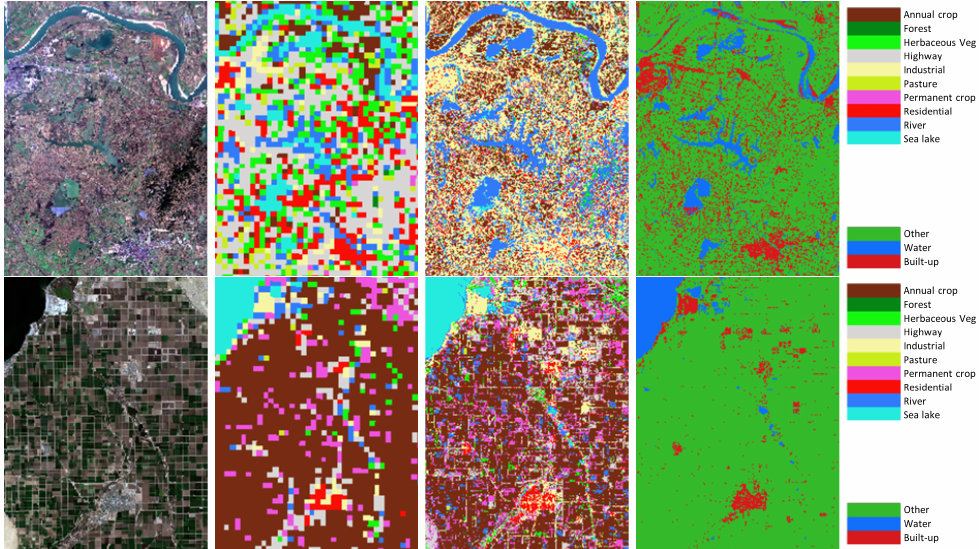
Figure 6. Transfer learning on geographic locations different than the location from which the training samples have been selected. Two exemplar areas from China and USA in the first and second row, respectively; all the training samples have been selected from Europe. The columns from left to right: